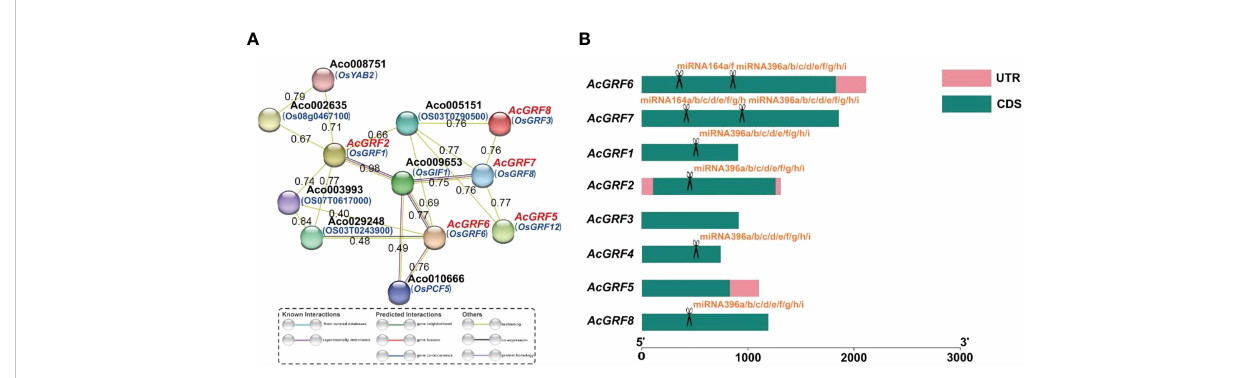
FIGURE 6 Predicted protein interaction network of AcGRF proteins and miRNA target sites in AcGRF genes. (A) Protein interaction network predicted using AcGRF orthologs from rice. (B) Predicted miRNA targets in the AcGRF genes. The scissors represent the miRNA and its targeted AcGRF gene, with penalty score ≤ 5 and lower expectations indicating higher prediction